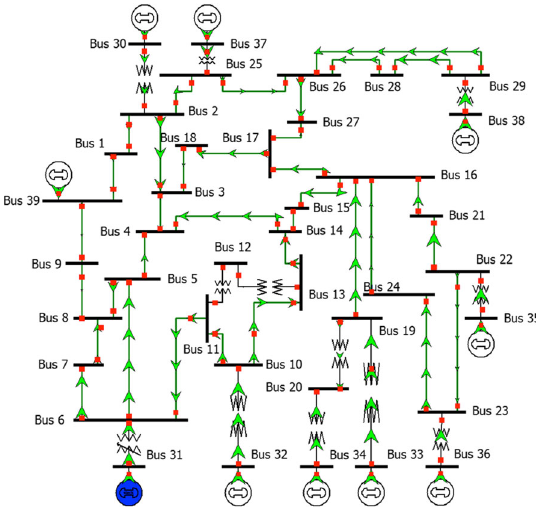
Fig. 17 10-machine 39 bus New England system [43]